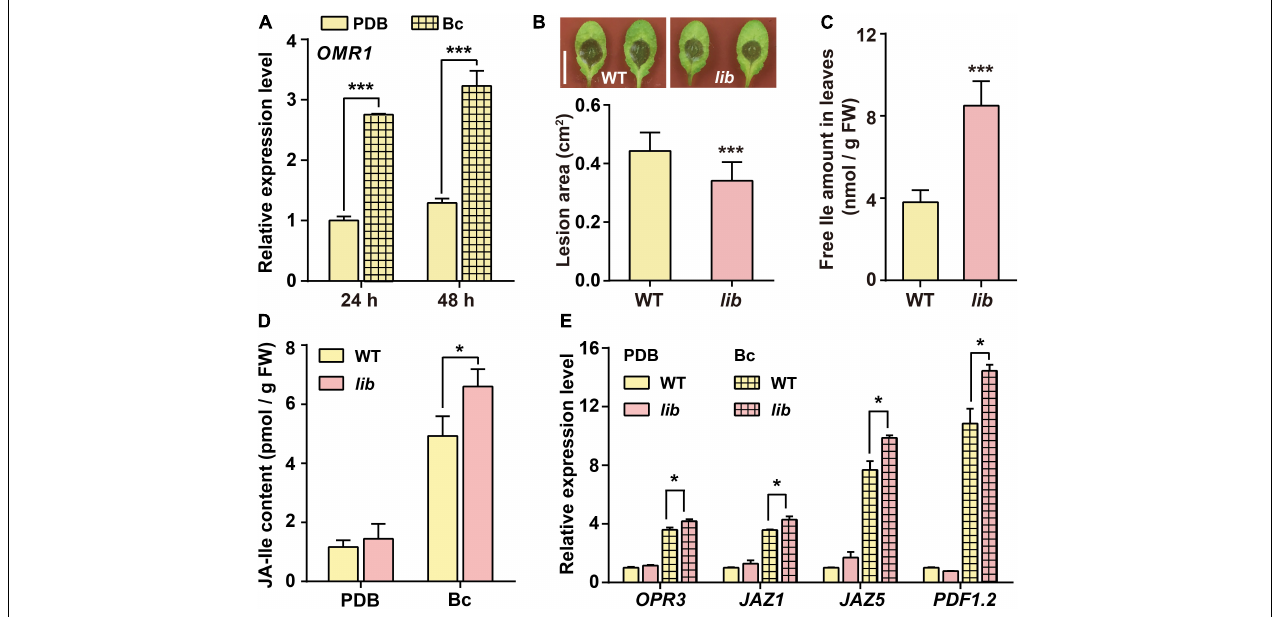
FIGURE 2 | lib mutant shows enhanced plant resistance to B. cinerea . (A) Transcript level of Ile biosynthetic gene OMR1 in WT leaves. Four-week-old WT plants were sprayed with Potato Dextrose Broth (PDB) or B. cinerea spores suspension (Bc) for 24 and 48 h. Data are means ± SD ( n = 3 samples, each sample contains three leaves). ACTIN8 was used as the internal control. (B) Representative phenotype and lesion area of WT and lib leaves after B. cinerea infection for 2 days. Data are means ± SD ( n = 61–69 leaves). (C) Free Ile amount in the leaves of WT and lib seedlings. Five-day-old seedlings were transferred to vertical MS medium (1.2% agar) plates for 10 days, and then leaves were collected for Ile measurement. Data are means ± SD ( n = 7–10). (D,E) JA-Ile content (D) and transcript level of JA biosynthetic gene OPR3 , JA-responsive genes JAZ1 and JAZ5 , and defensive gene PDF1.2 (E) in the leaves after indicated treatments. Three-week-old WT and lib plants were sprayed with PDB or B. cinerea spores suspension (Bc) for 24 h. Then, rosette leaves were collected for quantification of JA-Ile contents and transcript level. Data are means ± SD. In panel (D) n = 3–7 samples. In panel (E) n = 3 samples, each sample contains three leaves; ACTIN8 is used as the internal control. Asterisks indicate significant differences (Student’s t -test, * p < 0.05; *** p <